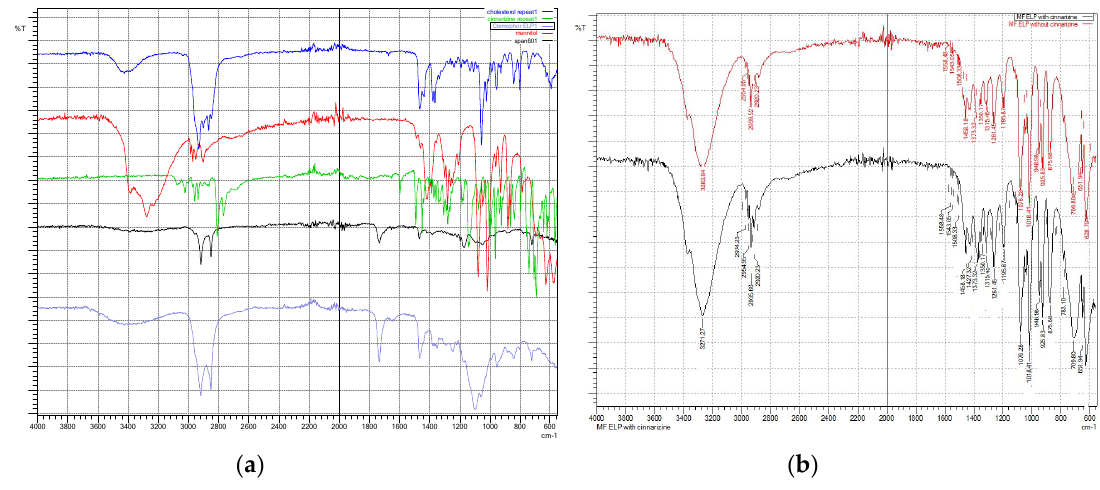
Figure 7. ( a ) FTIR spectra taken for individual ingredient: cholesterol (blue), mannitol (red), cinnarizine (green), Span ® 60 (black) and Cremophor ® ELP (purple); ( b ) FTIR spectra for MF-based formulations 3 and 4.